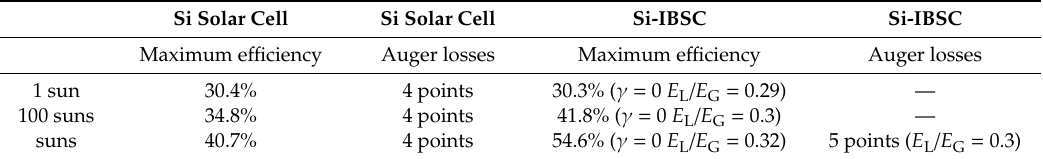
Table 1. Summary of the limit efficiencies for a single gap silicon solar cell and a silicon IBSC including the effects of Auger recombination considering a cell thickness of 200 μ m.